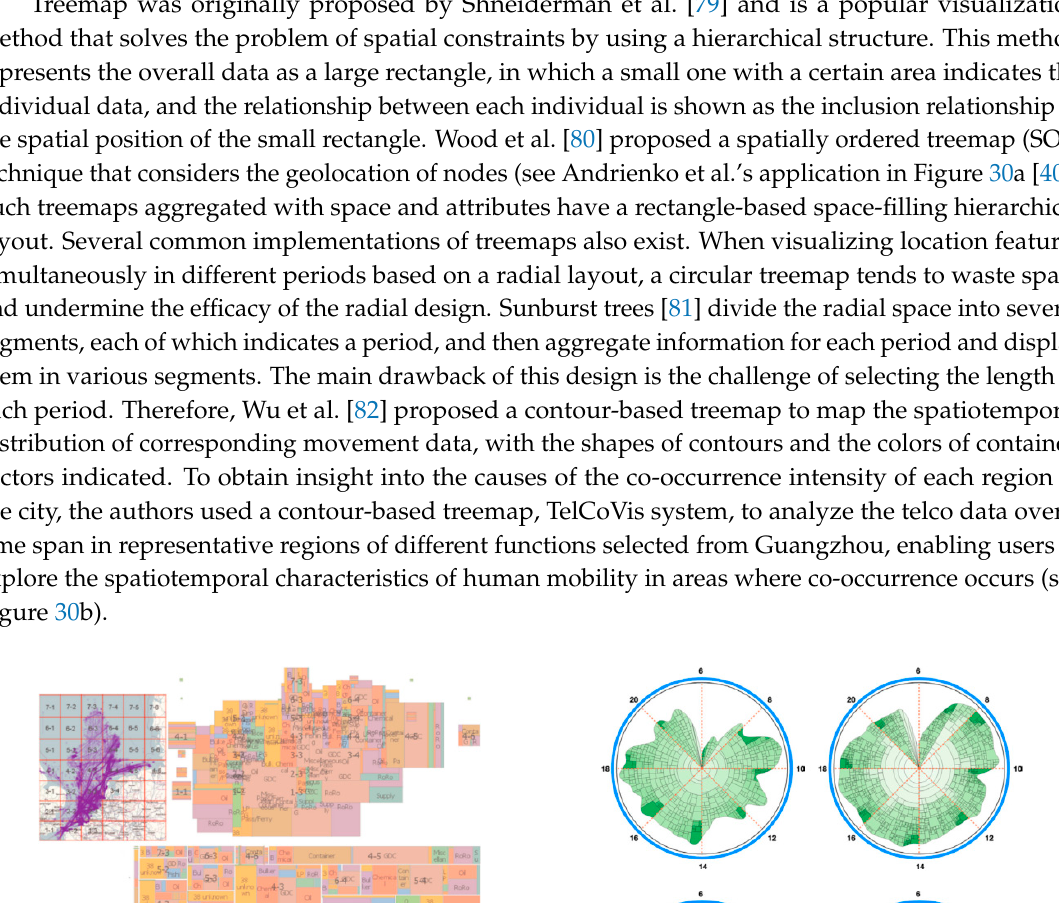
Figure 29. Visualizations of cluster detecting results [77].